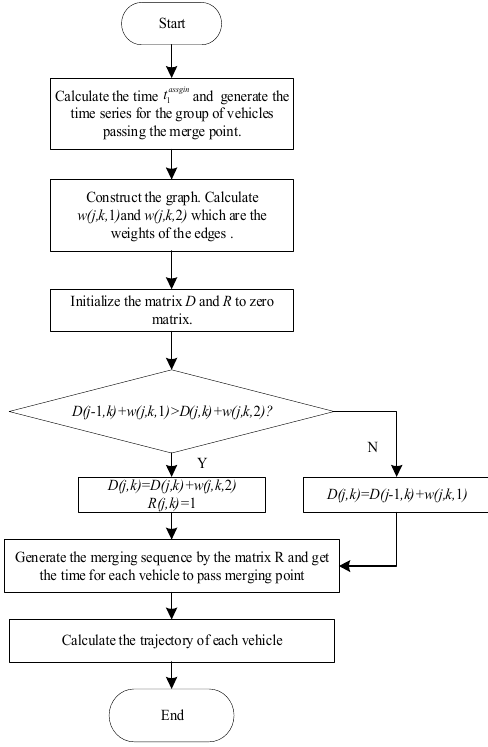
Figure 4. The flow chart of the improved shortest path algorithm.